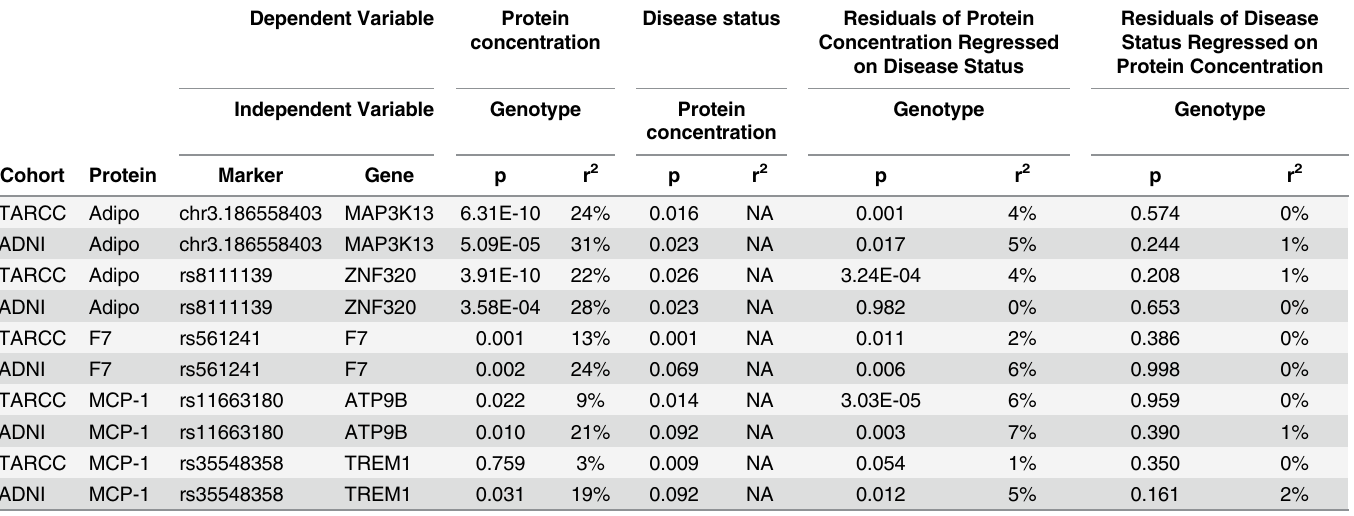
Table 5. Results of conditional regression analyses. For each regression equation, dependent variables are listed in the top row, independent variables in the second row. For conditional regressions (two columns to the far right) the dependent variables were the residuals from an initial regression and the inde- pendent variables were the genotypes of candidate SNPs. [Protein~Disease status] indicates that protein concentration was the dependent variable and dis- ease status was the independent variable in the initial regression. Similarly, [Disease status~ Protein] indicates that disease status was the dependent variable and protein concentration was the independent variable in the initial regression. Correlation statistics indicating the amount of variance explained by the independent variable is presented where appropriate for each regression. Results of regression analyses recapitulated the GWAS results for F7, MCP-1 and adiponectin (column one). In addition, there were significant associations between AD status and blood concentrations of F7, MCP-1 and adiponectin (column two). Conditional regression analyses suggested that candidate SNPs contributed to variation in protein concentration independent of AD status (col- umn three). None of the results of regressions interrogating whether genotypes contributed directly to disease risk independent of protein endophenotype were significant (column four). However, due to insufficient statistical power, it was not possible to determine the true relationship between these